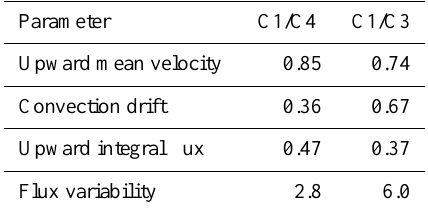
Table 1. List of rank correlation coefficients of invariant latitude series of upward velocity, convection drift and upward integral flux between C1 and C4, and between C1 and C3, on 23 September 2001. The last row indicates the corresponding flux